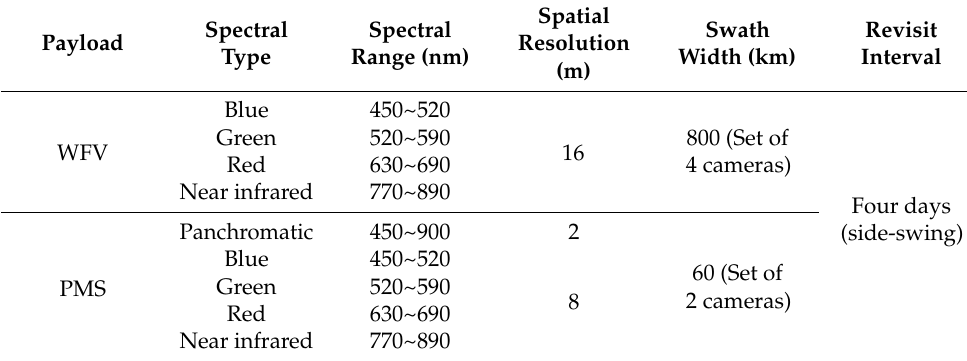
Table 2. Technical parameter of GaoFen-1 (GF-1) (wide field of view (WFV) and panchro- matic/multispectral high resolution